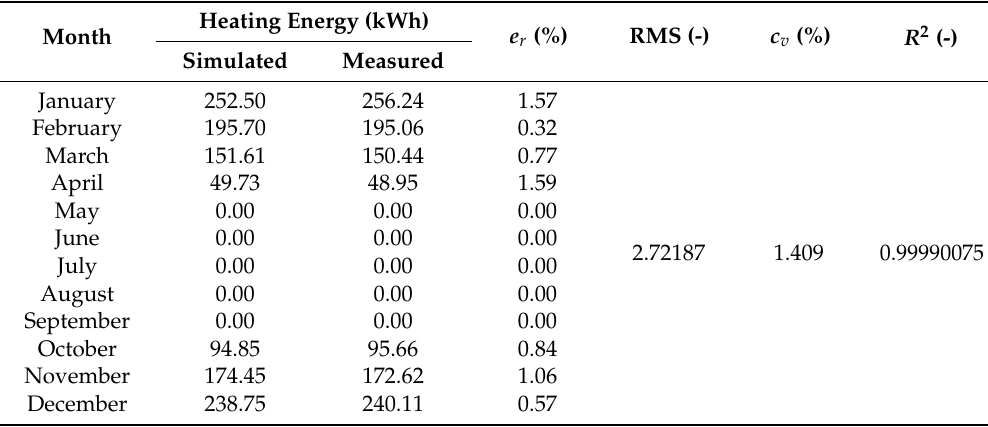
Table 3. Thermal energy used for office room heating.